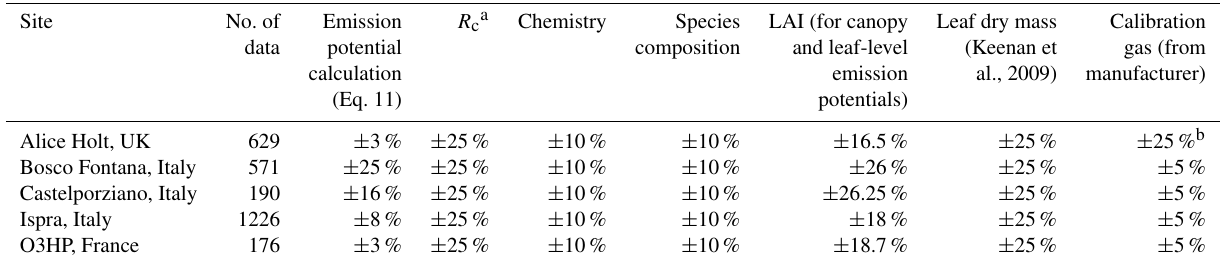
Table 3. Summary of uncertainties attributed to the various steps used in the calculation of emission potentials for each of the five measure- ment